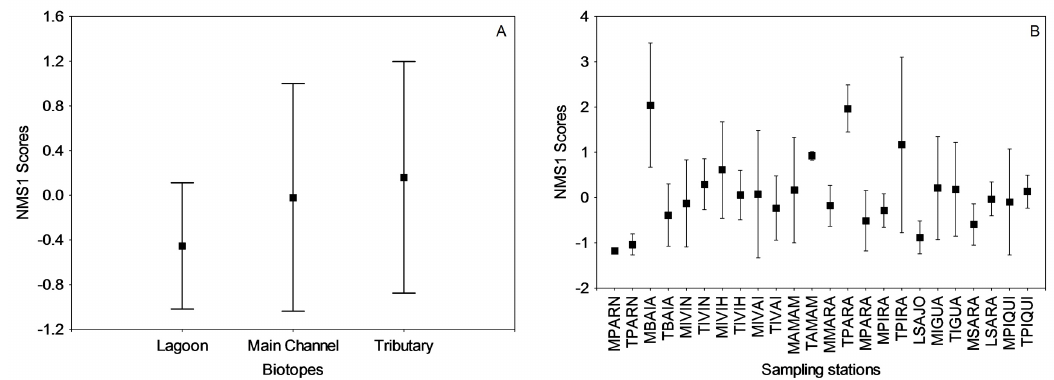
Figure 3. Mean variation of NMS axis 1 scores (two-dimensional solution, stress: 0.14) for spatial analysis: biotopes (A) and sampling sites (B) in relation to the structure and composition of fish larvae sampled between August and May 2015 in the Upper Paraná River floodplain (squares = mean; bars = standard